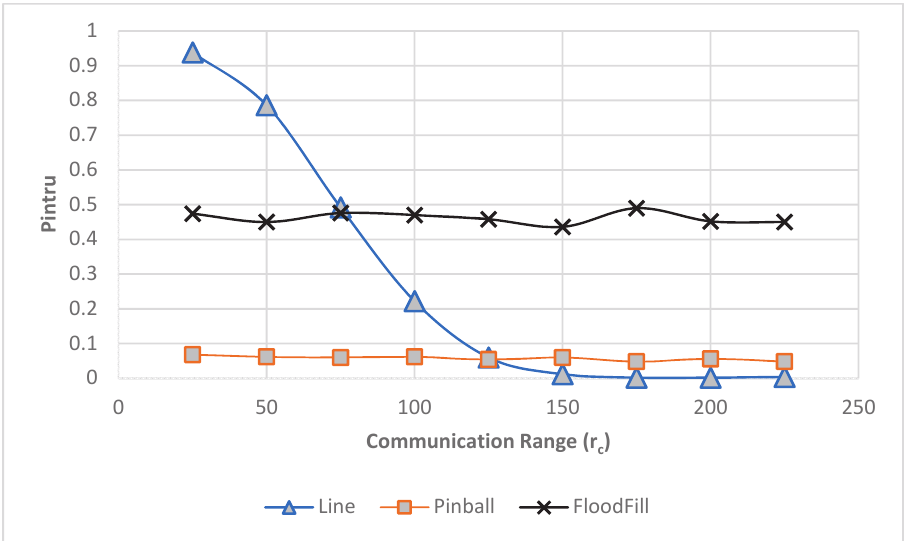
Figure 12. The escape probability ( P intru ) of an intruder that adopts the linear, pinball and flood-fill algorithms in a WSN with varying communication range r c